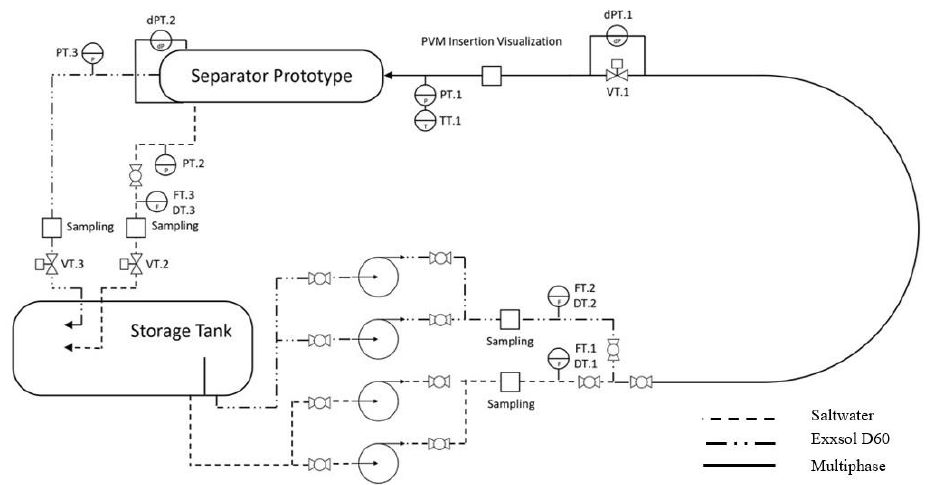
Figure 5. PI&D of the experimental system